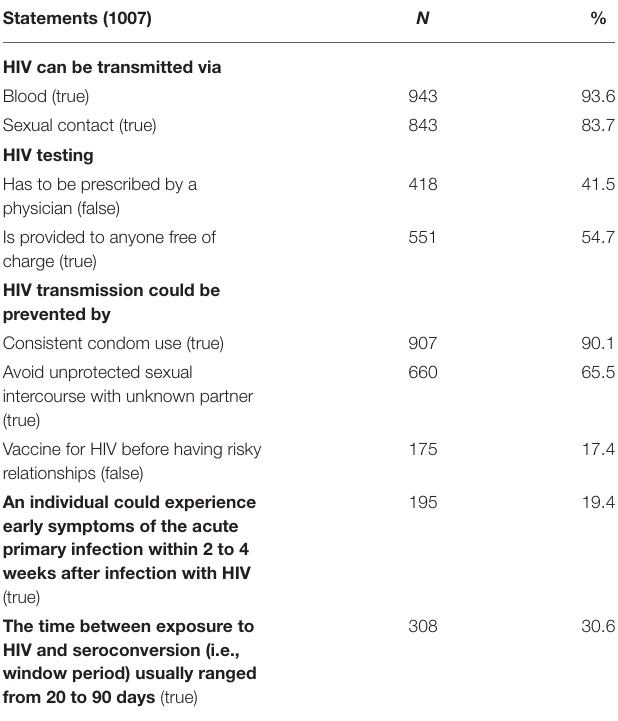
TABLE 1 | Respondents’ knowledge related to HIV